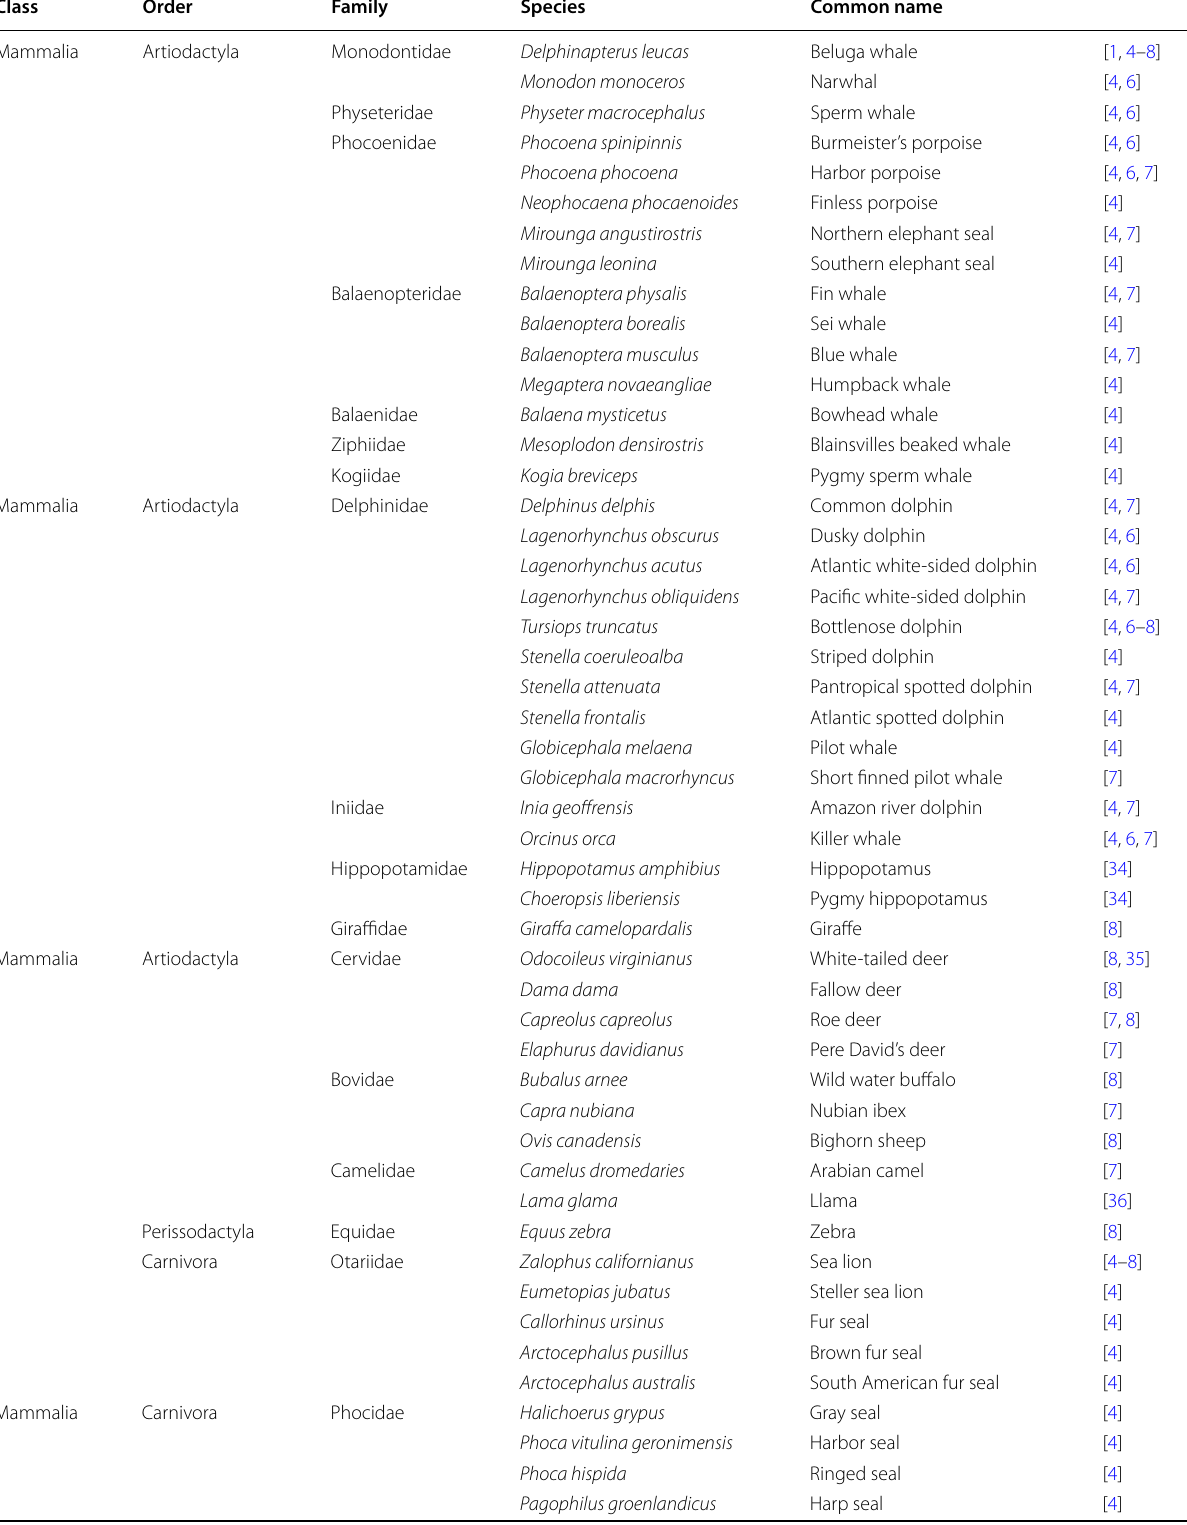
Table 2 Classification of vertebrate species that have been reported with